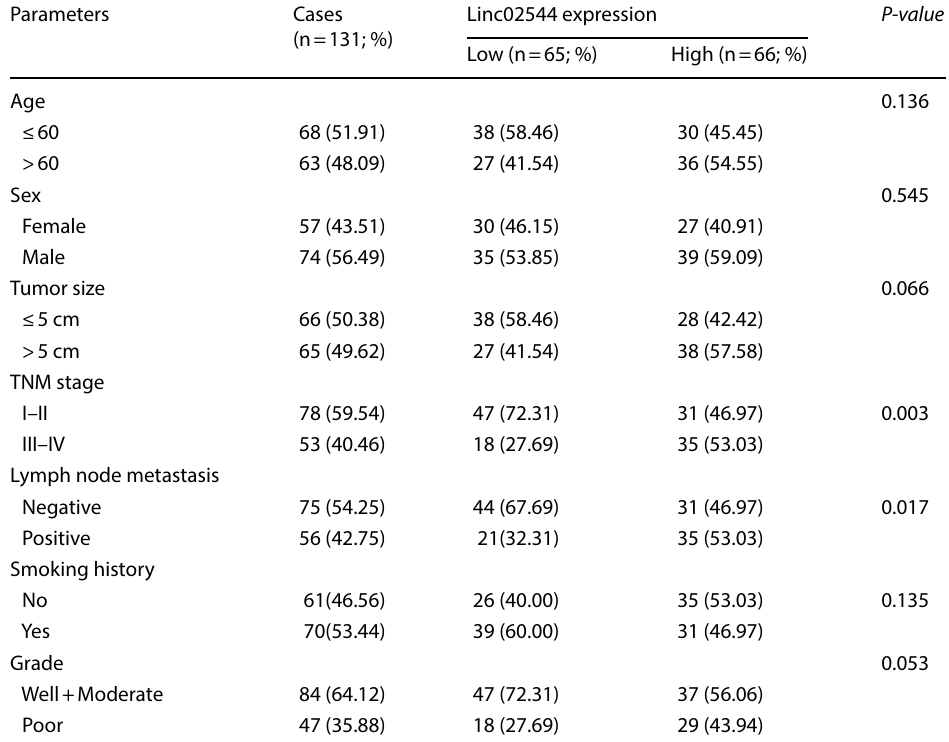
Table 1 Correlation of the linc02544 expression with clinical parameters in patients with LUSC